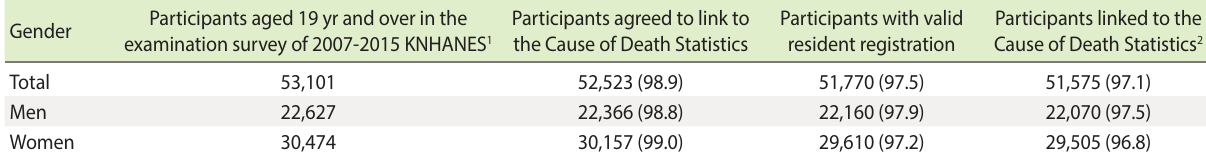
Table 2. Linkage information between 2007-2015 Korea National Health and Nutrition Examination Survey (KNHANES) and 2007-2019 Cause of Death Statistics (dataset version